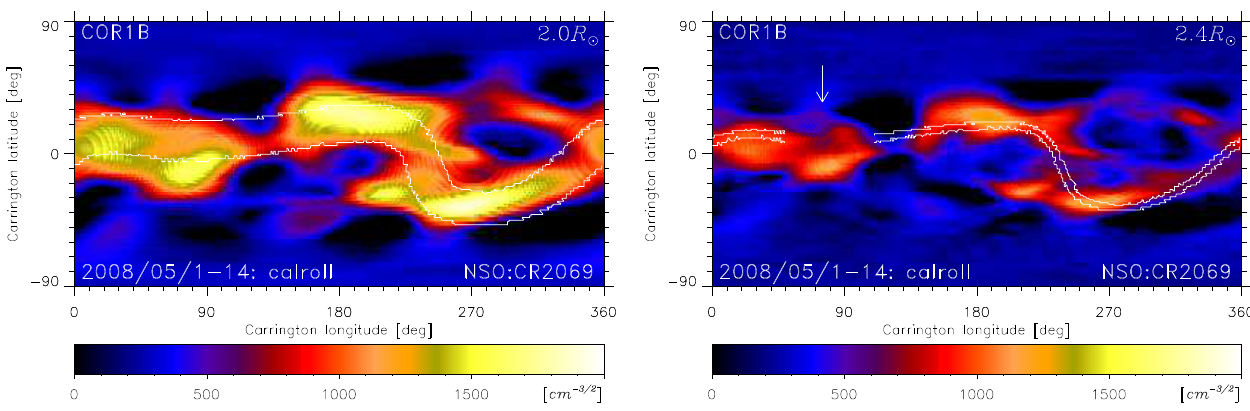
Fig. 4. Spherical cross-section of the reconstructed electron density in square root scale at heliocentric distances 2 . 0 and 2 . 4 R ⊙ (the distances are shown in the right upper corners). The reconstruction based on data obtained during 1–14 May 2008. The white lines are the boundaries between closed and open magnetic field lines for PFSS model with source surface at 2 . 5 R ⊙ corresponded for CR 2069. The part of the lines on the right panel between Carrington longitudes 50 and 110 ◦ are not shown in order to more clearly show the density structure in this region. However the lines in this region are almost horizontal.